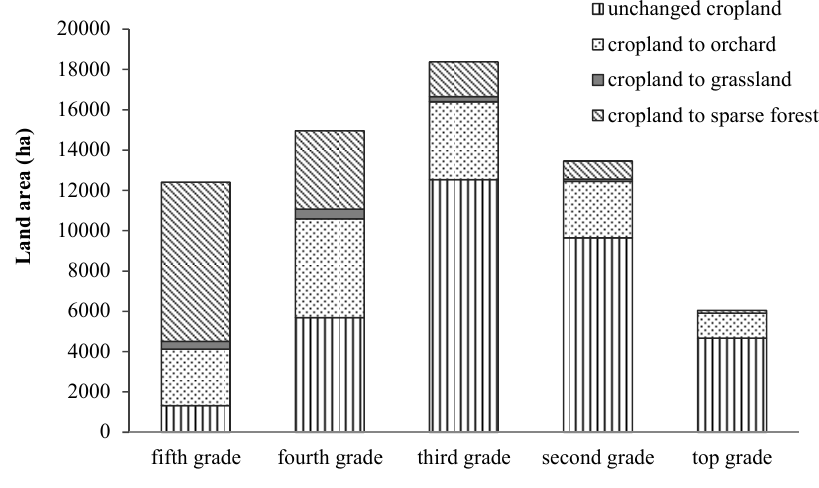
Figure 4. Distribution of converted cropland by different grades of physical